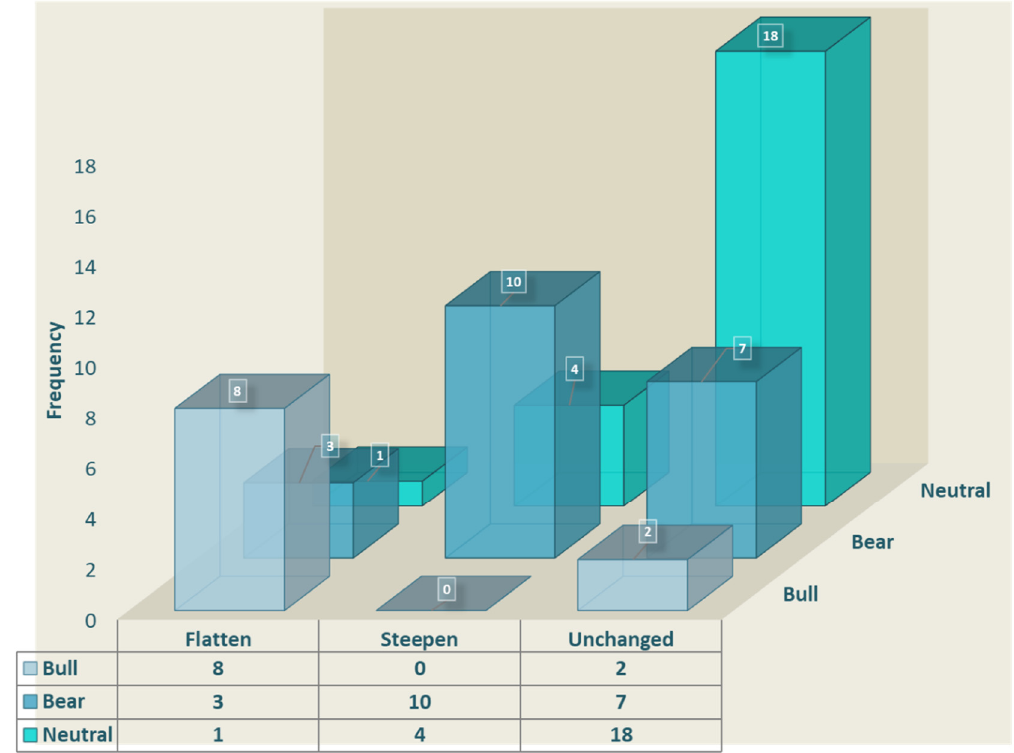
Figure 12. Weekly yield curve patterns in 2021. Source: Bloomberg yields, own computation of yield curve patterns.